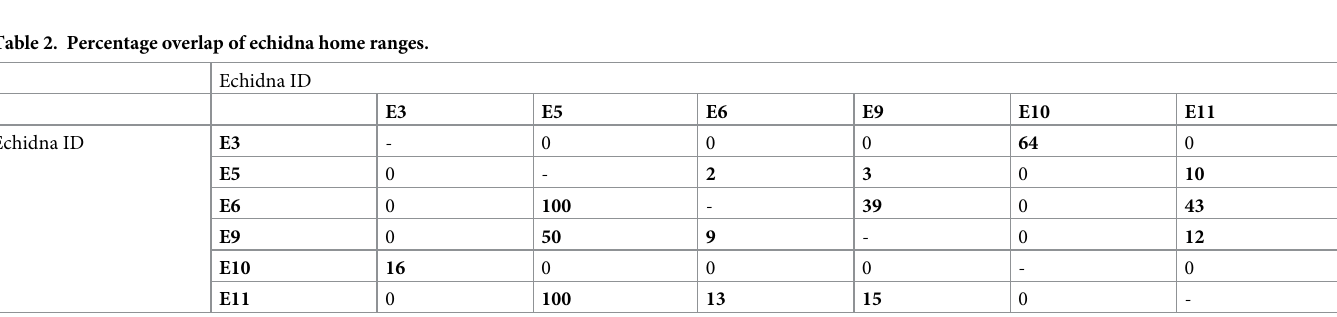
Table 2. Percentage overlap of echidna home